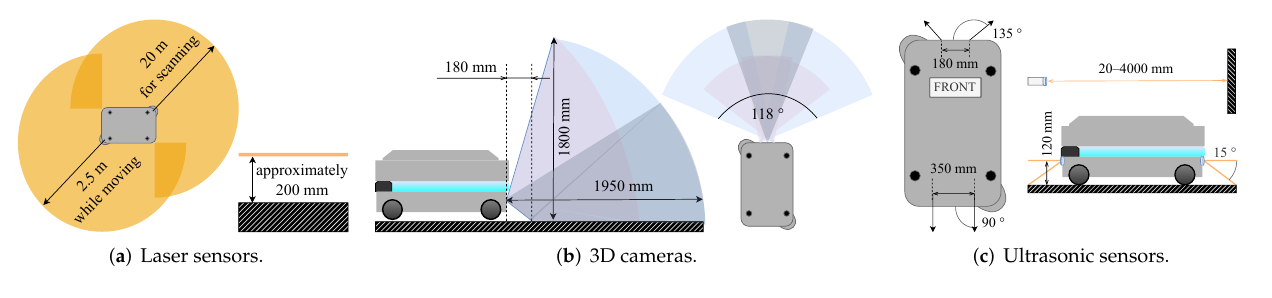
Figure 3. Obstacle detection system